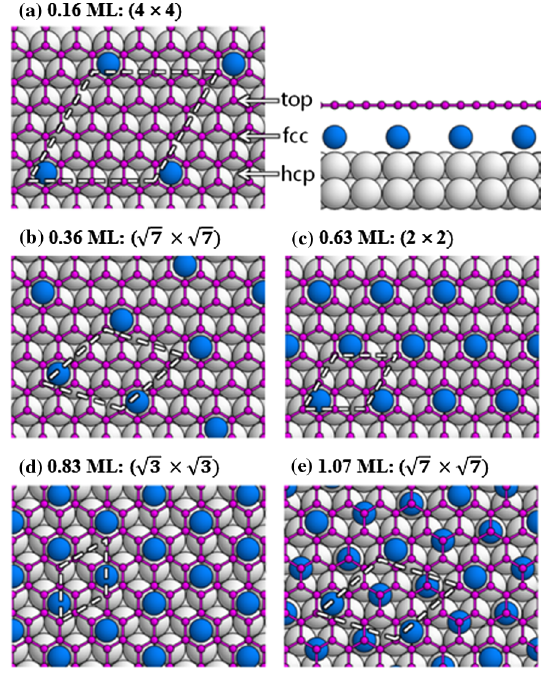
FIG. 1. Employed structural models for the Na-intercalated graphene/Ni(111) surface. Large, medium, and small balls represent the Ni, Na, and C atoms, respectively. 1 ML denotes one Na atom per five C atoms. Dashed lines represent the corresponding unit cells. Arrows in (a) indicate three high- symmetry surface